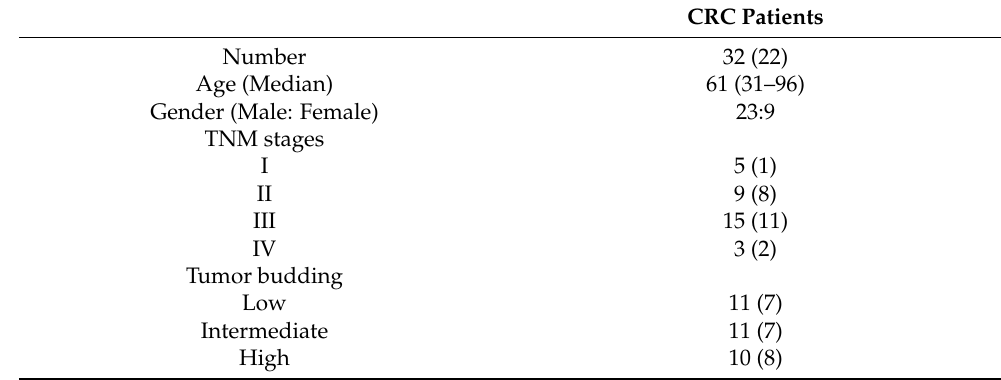
Table 1. Characteristic features of study